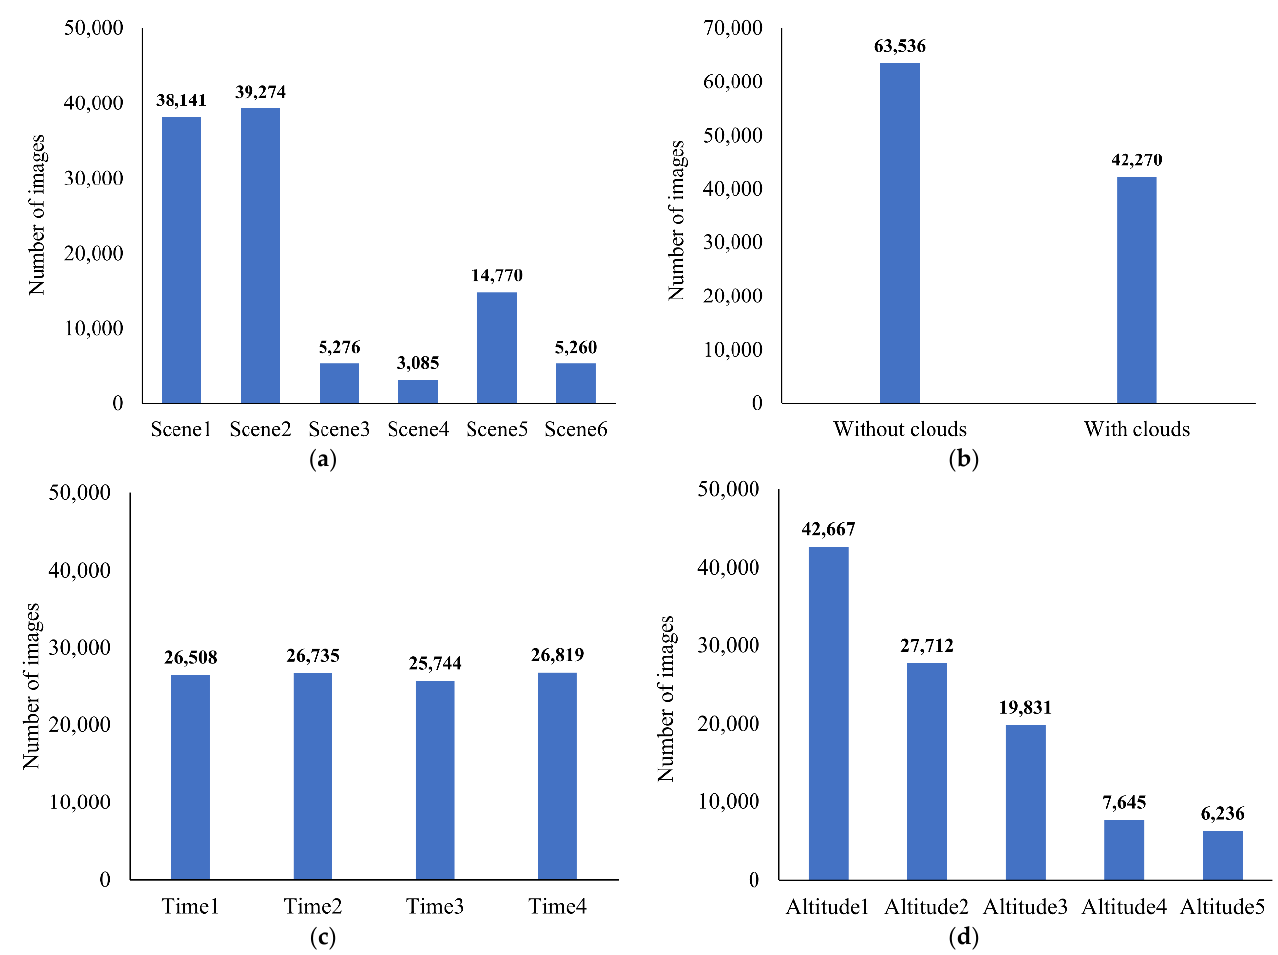
Figure 4. Scene statistics for the UnityShip dataset, including: ( a ) the number of images from different scenes, ( b ) whether they contain clouds, ( c ) different collection altitudes, and ( d ) different collection times.